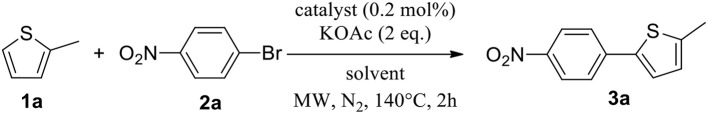
C-H direct arylation of 2-methythiophene with 4-bromonitrobenezene.